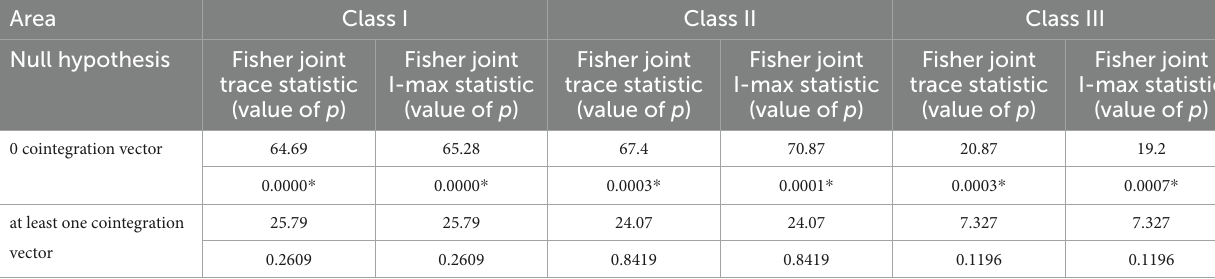
“ * ” indicates the difference of root test results, and the more * , the greater the difference.